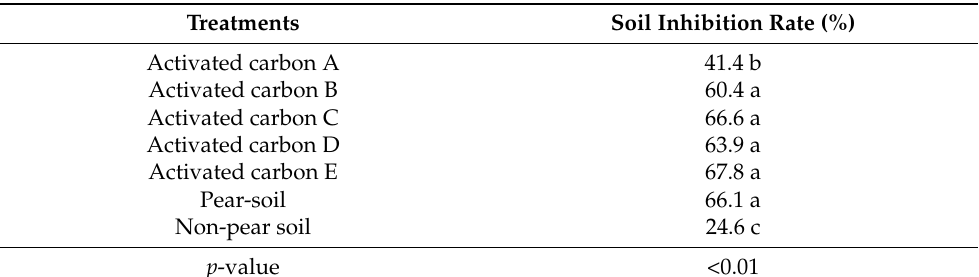
Table 2. Selection of activated carbon suitable for Japanese pear using the rhizosphere soil assay method.